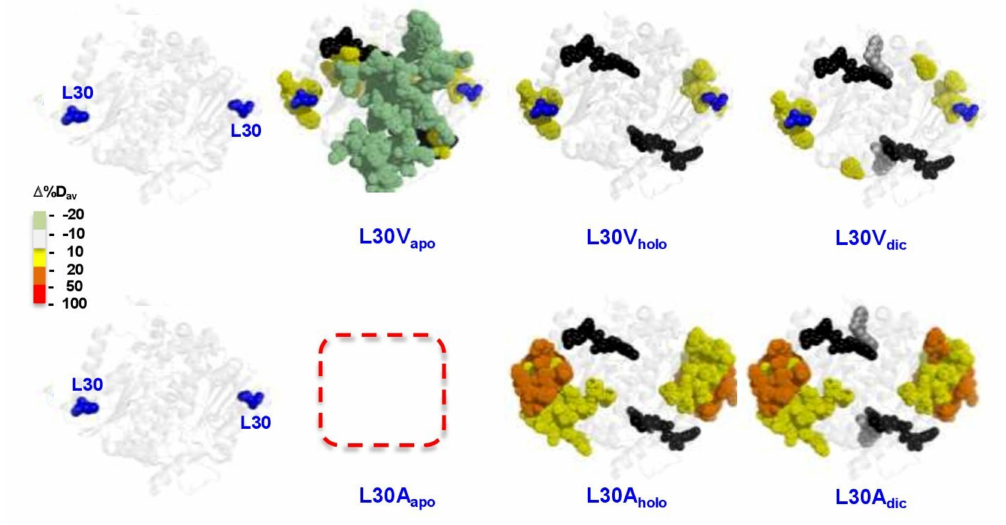
Figure 8. Representation of the changes in local stability (as ∆ %D av ) due to mutations L30V and L30A vs. WT. Results are shown as indicated in the color scale for different ligation states (NQO1 apo , NQO1 holo and NQO1 dic ). Note that light green indicates slight stabilization. FAD and Dic are shown as spheres (black and grey, respectively). The structural model used for display was PDB 2F1O